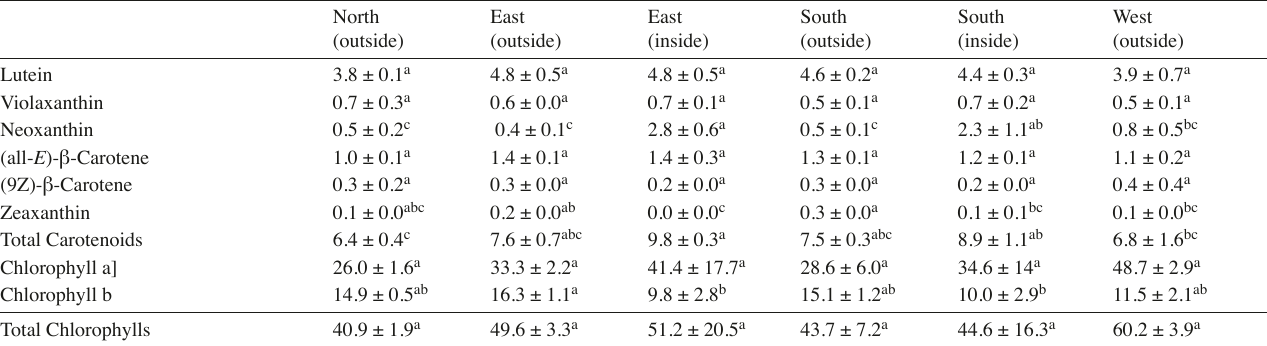
Tab. 4: Concentration of carotenoids and chlorophyll a and b [mg * 100 g -1 FW] in kale samples harvested after 7 weeks of growth under urban gardening condi- tions in northern, southern, western, and eastern locations, including 2 indoor locations (east and south). Different letters indicate significant differences of means according to Tukey’s test ( p ≤ 0.05).